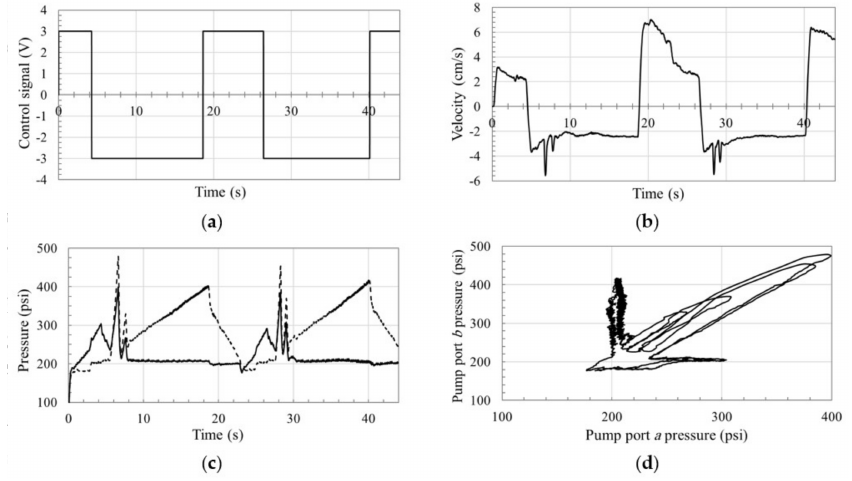
Figure 12. Performance of circuit using CC-SHV for a 41 kg attached mass: ( a ) control signal; ( b ) actuator velocity; ( c ) pressures at the pump ports a (solid line) and b (dotted line); ( d ) pump pressure